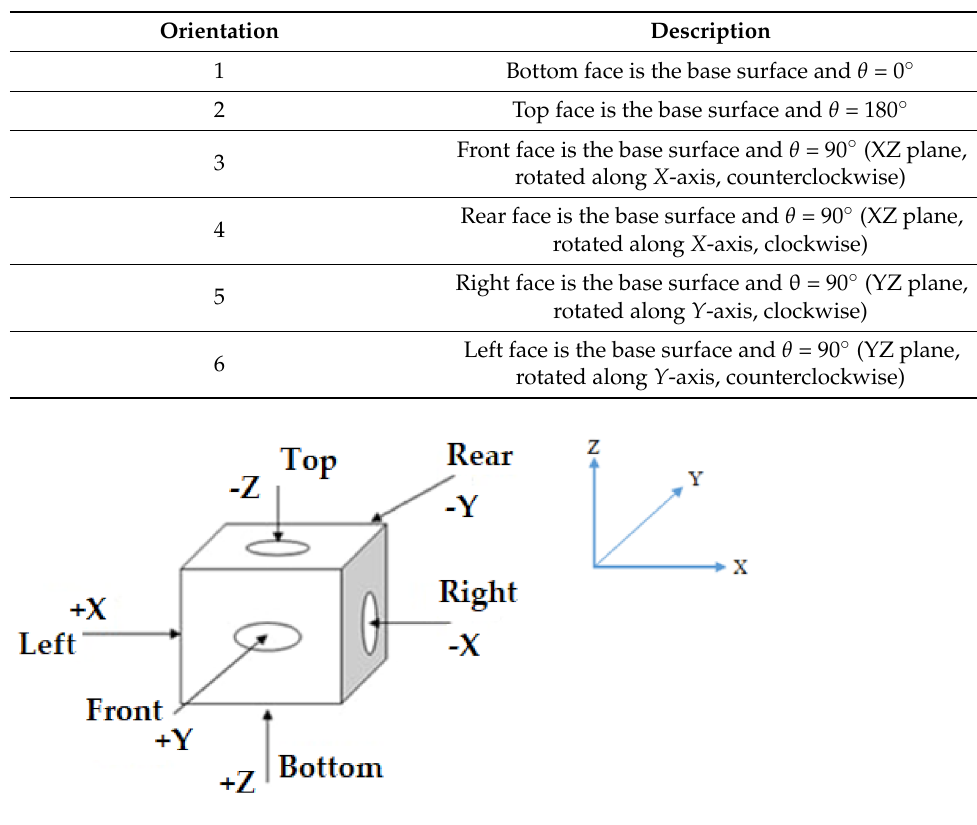
Figure 2. Designation of component’s